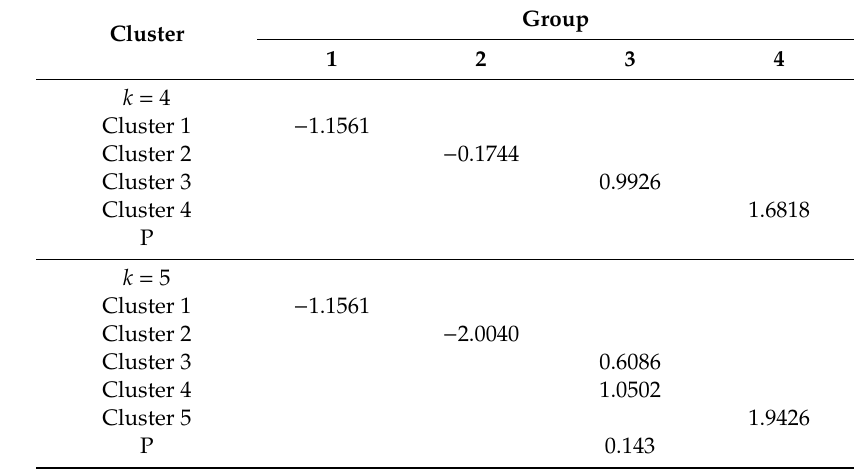
Figure 10. The geographic clustering results. 6. Decision Tree-Based HTAs Cause–Consequence Analysis In order to understand the correlation among the hazmat properties, accident characteristics, and the consequences of HTAs, the decision tree method was used to identify which characteristics define the specified groups, and to outline which specific variables have the most substantial impact on group differentiation. A decision tree is a tree-like collection of nodes intended to create a decision on values affiliation to a class or an estimate of a numerical target value. Each node represents a splitting rule for one specific attribute. For classification, this rule separates values belonging to different classes. Generally, the chi-squared automatic interaction detection (CHAID) analysis is one way to determine how variables combine to determine group membership [23]. It is based on the target variable (independent variable; the independent variables of CHAID can only be classified)